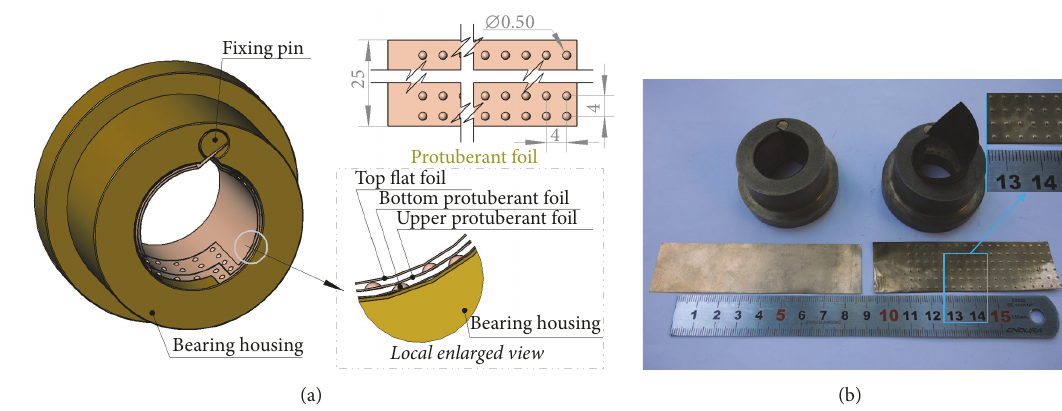
Figure 5: Schematic diagram and real picture of foil journal bearing in the turboexpander.